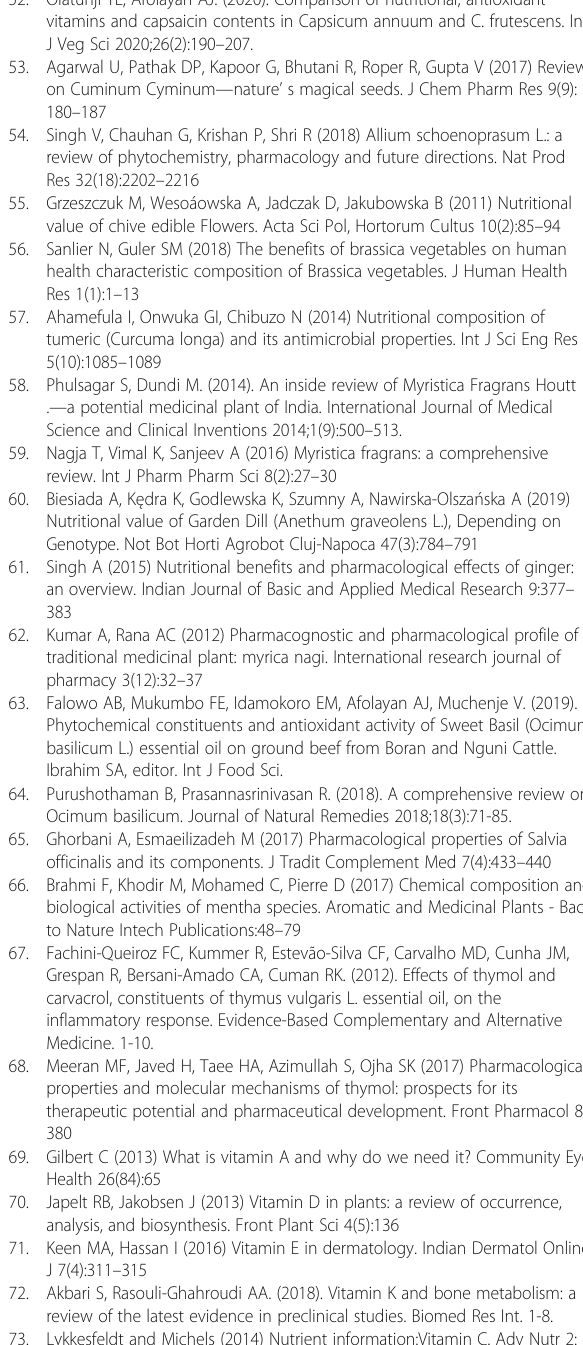
52. Olatunji TL, Afolayan AJ. (2020). Comparison of nutritional, antioxidant vitamins and capsaicin contents in Capsicum annuum and C. frutescens.